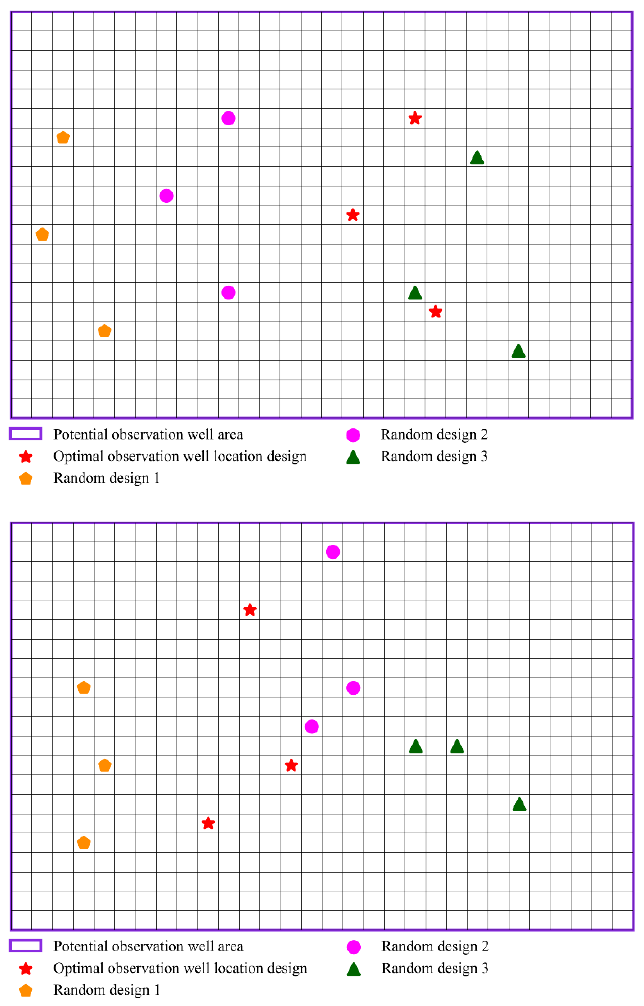
Figure 6. The OWLs of the optimal design and 3 random designs for Case 1 ( upper ) and Case 2 ( lower ).